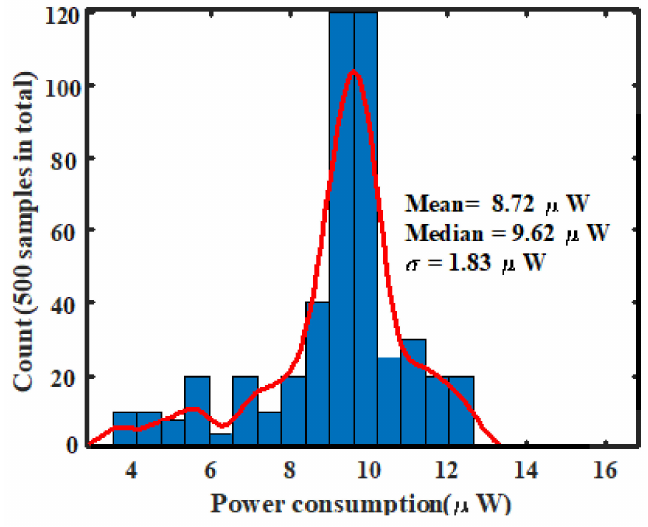
Figure 17. Histogram of power consumption against process variation.